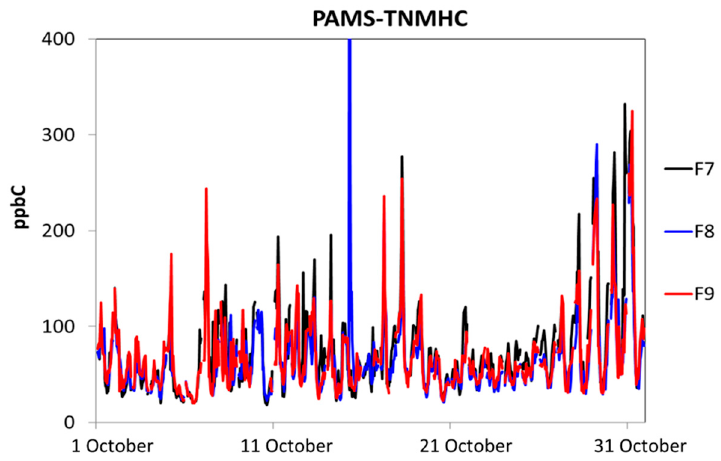
Figure 2. High synchronicity of three PAMS sites (F7, F8, and F9 in Figure 1) in the Petro–region as a means of validation of data quality. TNMHC, total level of non–methane hydrocarbon.